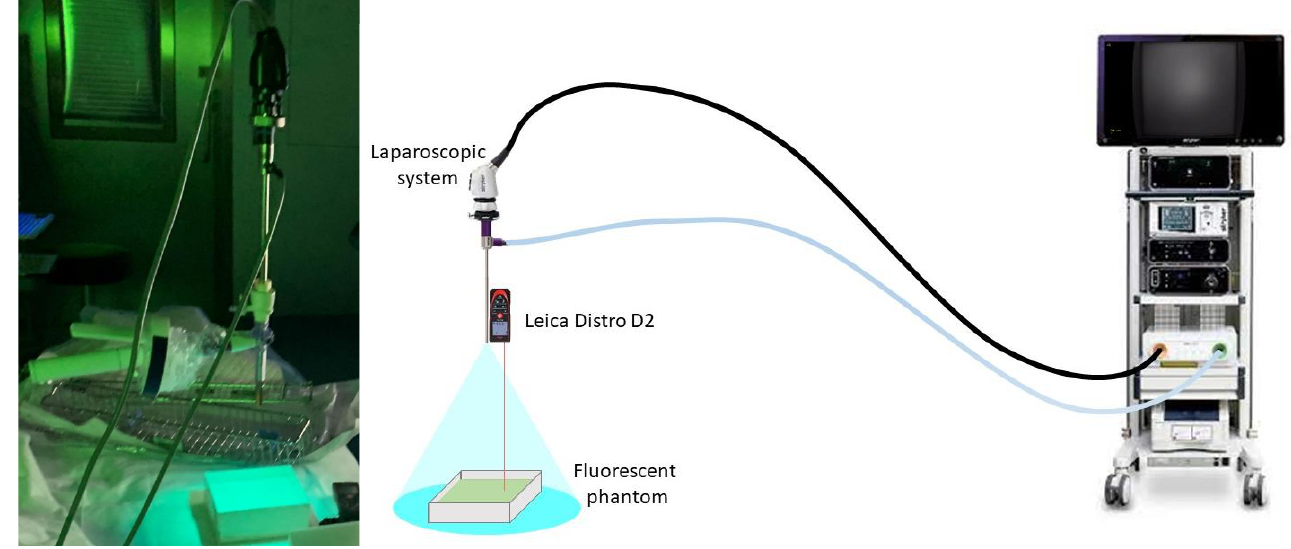
Figure 2. Experimental set-ups. The image at the left represents the phantom placed at 0-degrees with the endoscopic camera fixated at 16 cm.